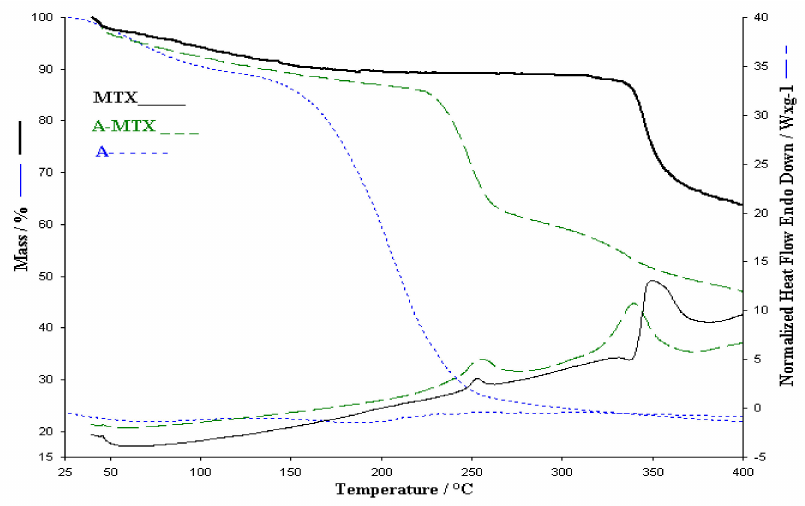
Figure 7. Comparative of TGA and HF for A, A-MTX and